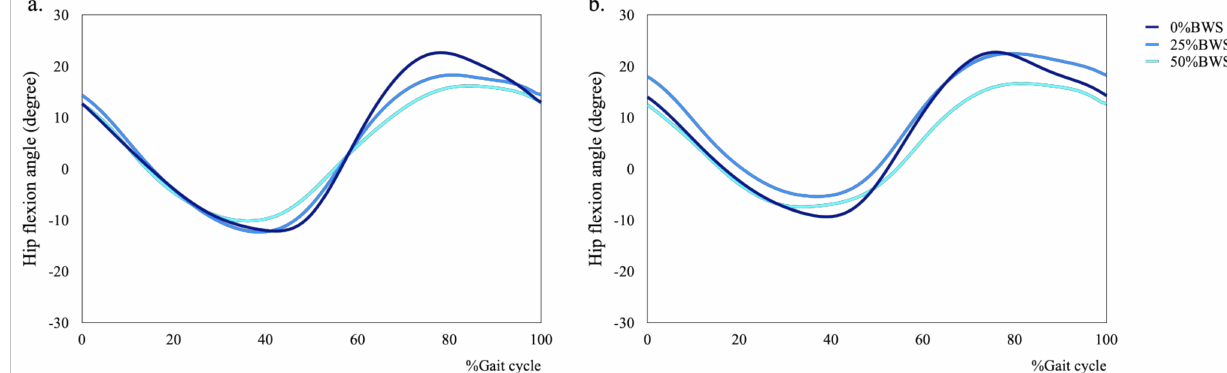
Figure 4. Mean plots of hip flexion during walking under 0%, 25% and 50%BWS conditions (( a ) male, ( b ) female).